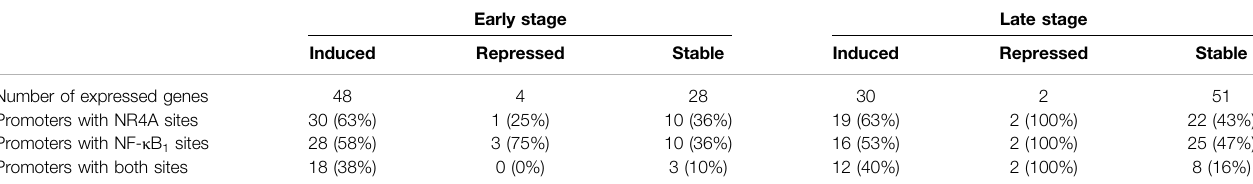
TABLE 1 | Consensus binding sites in promoters of differentially and stably expressed